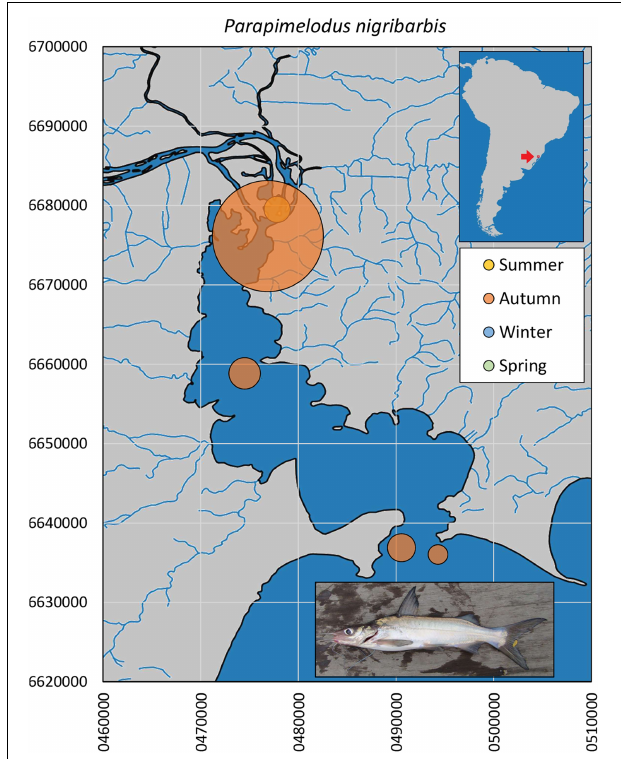
FIGURE 5 | Spatial and seasonal relative abundance of L. grossidens in Guaíba Lake, southern Brazil. Bubble area proportional to number of captures per site ( n = 134 individuals). Fish photograph from Timm, C.D. available at Fishbase.com. Vector map background from FEPAM open database (http://www.fepam.rs.gov.br/biblioteca/geo/bases_geo.asp). 22J UTM